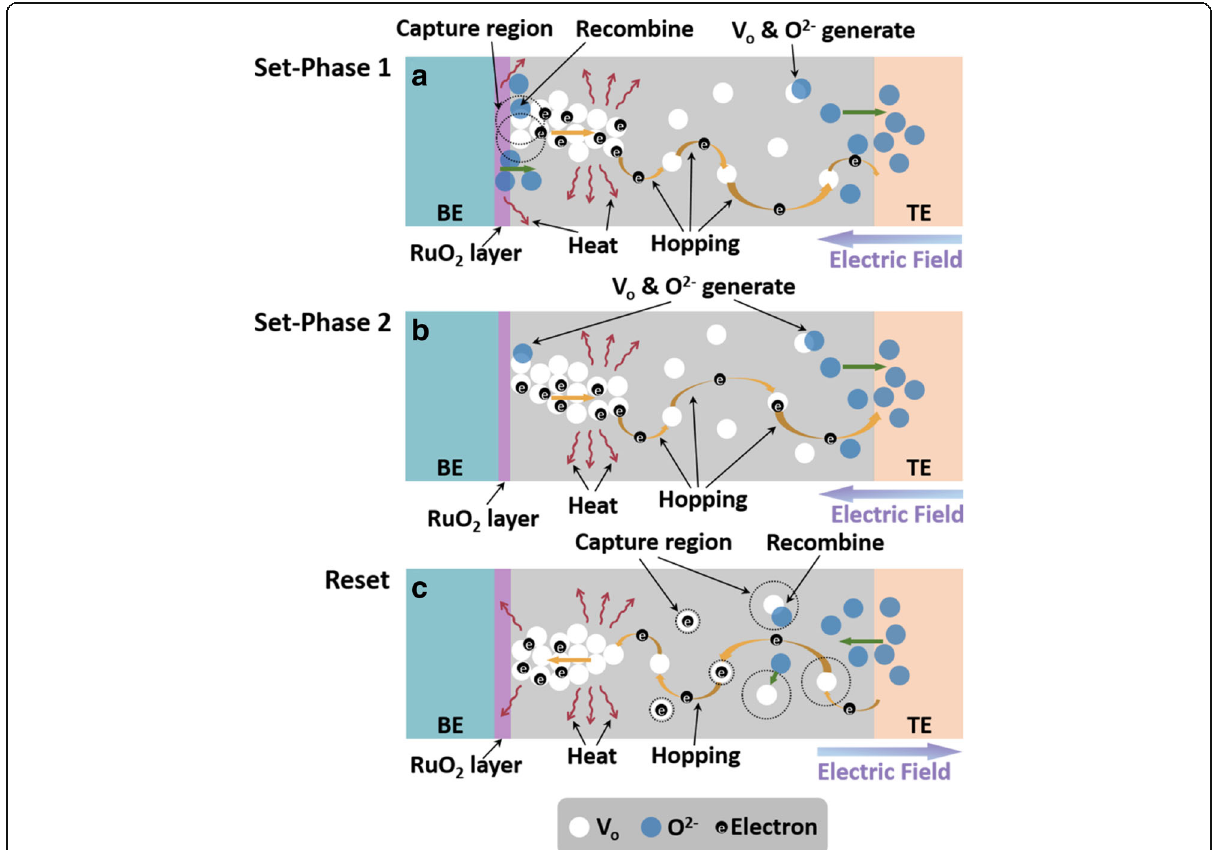
Fig. 5 Physical processes of resistive switching in Ru-based RRAM. a NDR effect (set-phase 1). b Common SET (set-phase 2) processes. c RESET process of the device